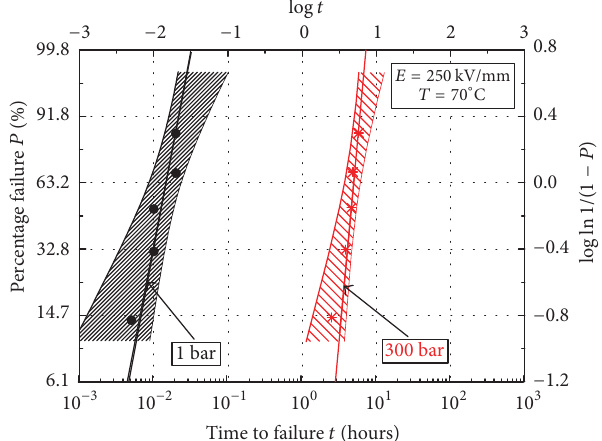
Figure 4: Representation of the ageing data of XLPE, according to the inverse power model, at 1 and 300 bar and 70 ∘ C. The bars to each line in this plot are 90% confidence